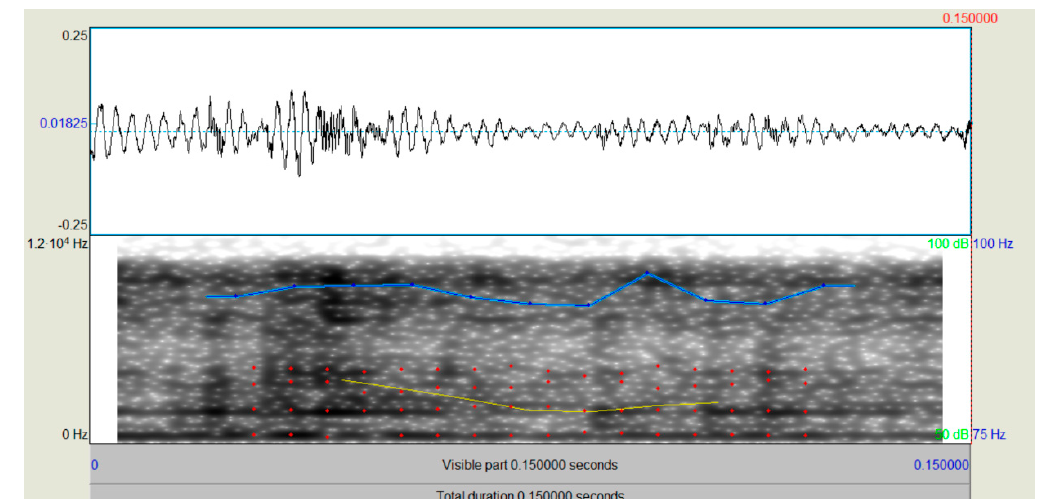
Figure 8. Short audio waveform segment and audio signal spectrogram for a “Cloudburst” case.